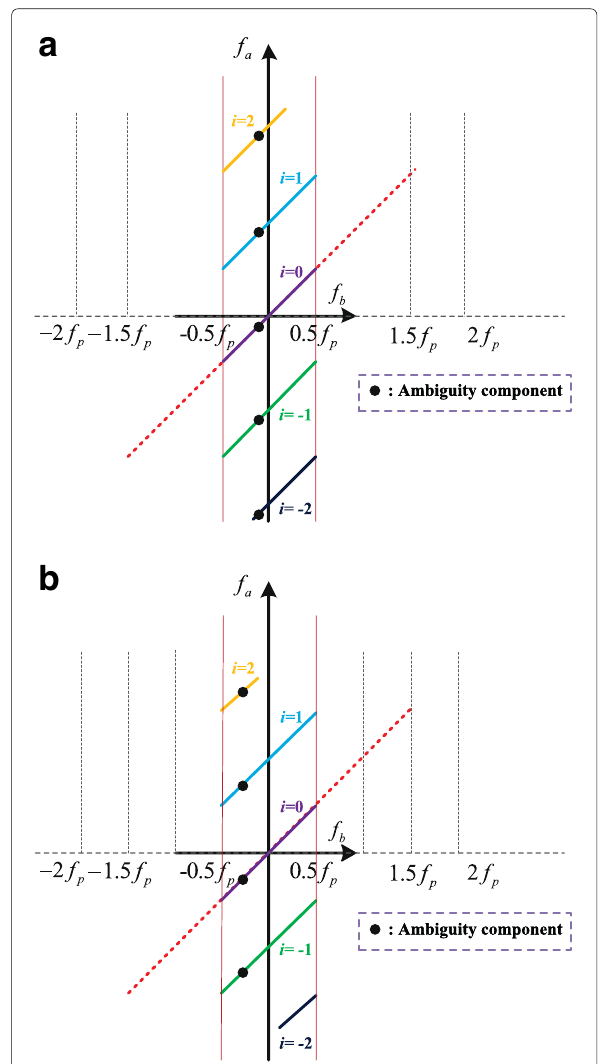
Fig. 3 The DSDs with different number of channels. a The number of channels is odd, taking M = 5 as an example. b The number